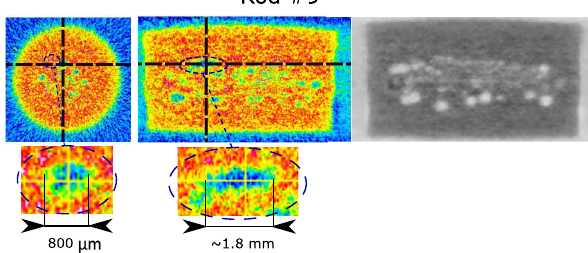
FIG. 12. Zoom-in images of the neutron tomography corre- sponding to rod No. 9, which apparently is the most damaged one. Voids with a size of ∼ 800 μ m in radius by ∼ 1 . 8 mm in length can be